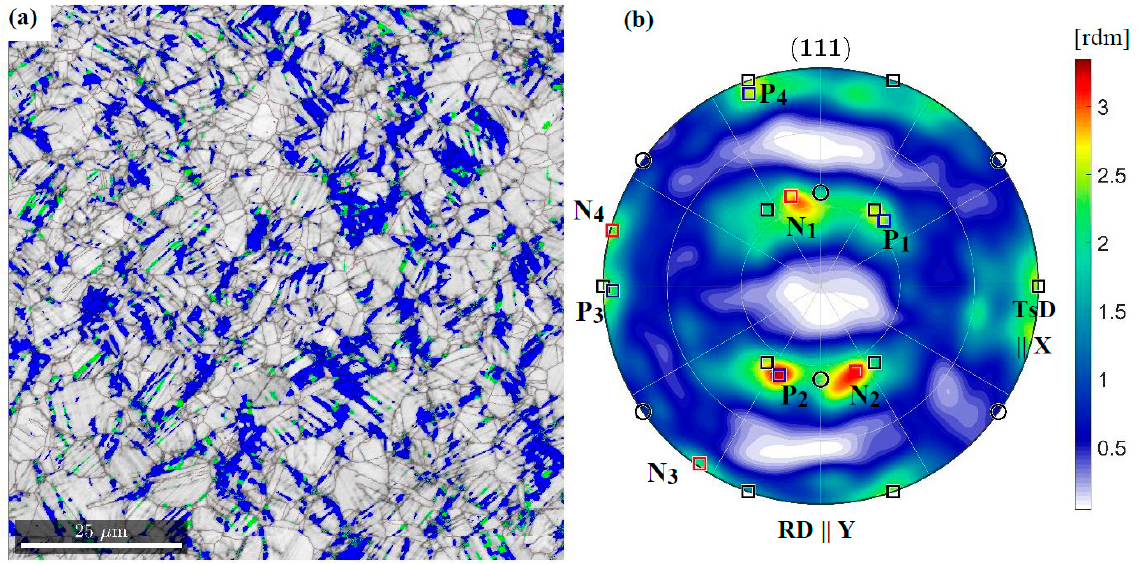
Figure 10. Microstructure of the representative region located 2 mm from the fracture surface. ( a ) Image quality map of austenite matrix with arising α ’ martensite (blue) and ε martensite (green). ( b ) {1 1 1} pole figure for austenite and its two most preferred orientations (P, N).